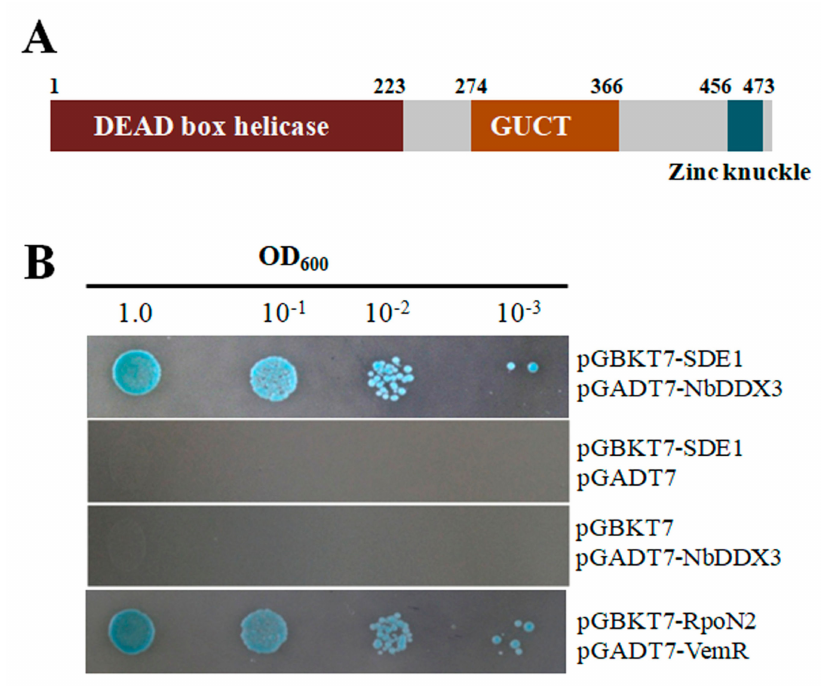
Figure 2. Screening and characterization of NbDDX3 that interacted with SDE1 from N. benthamiana. ( A ) NbDDX3 domain structures encoded by cDNA harbored in pGADT7. Di ff erent color boxes indicate the locations of DEAD-box helicase, RNA-binding GUCT, and zinc knuckle. ( B ) AH109 cells transformed with pGADT7 plasmids and pGBKT7-SDE1 grown on SD / -Ade / -Leu / -Trp / -His media supplemented with 20 µ g / mL X- α - galactosidase. The interaction between VemR and RpoN2 was used as a positive control. Y2H assays were repeated three